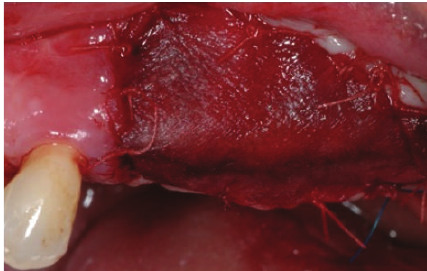
Figure 8: A collagen membrane has been placed in order to favor the soft tissue healing.